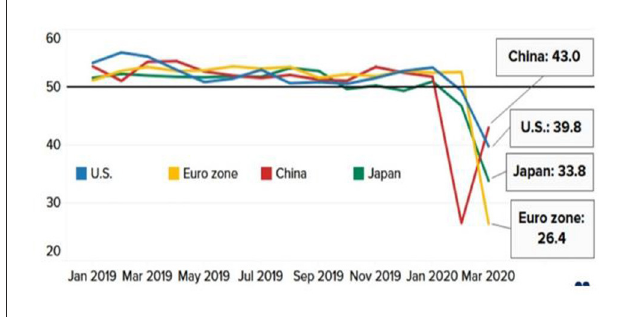
FIGURE7 Services activity in major economies. Source: IHS Market, Caixin, au Jibun Bank, Refinitiv.